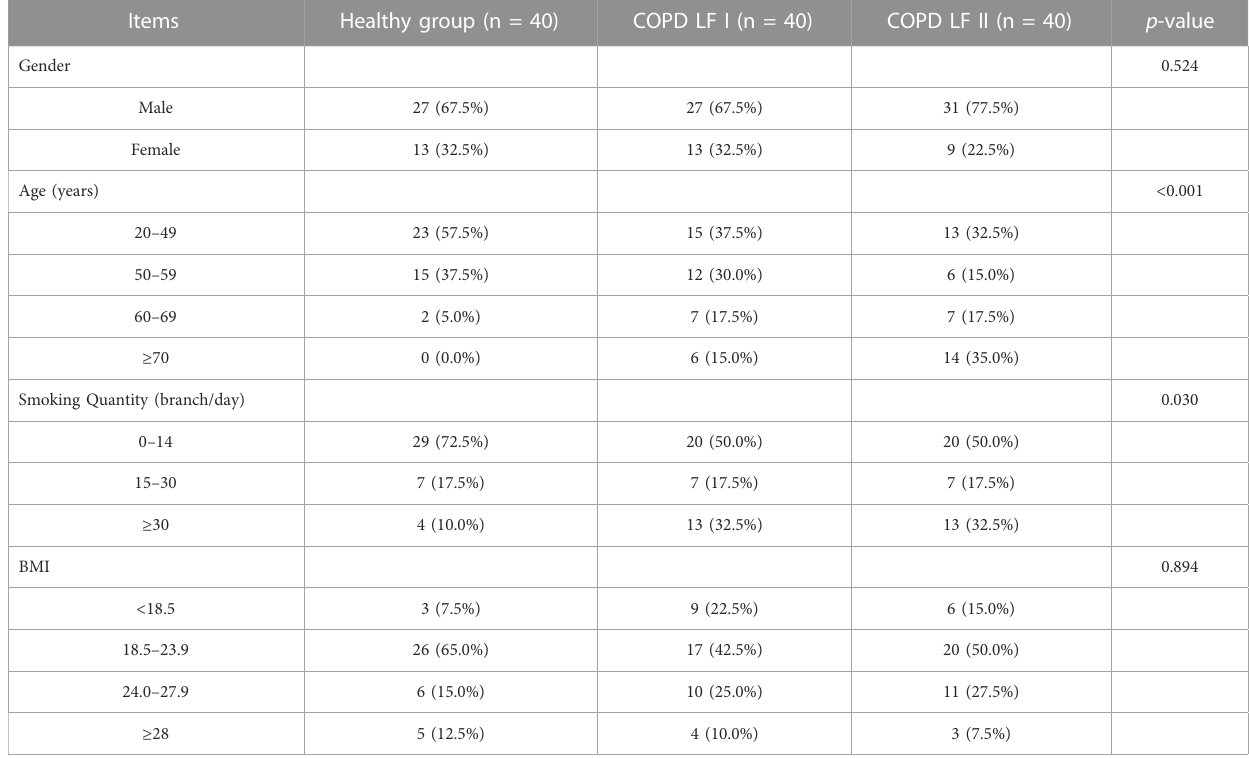
TABLE 1 Comparison of baseline information among the three groups. Items